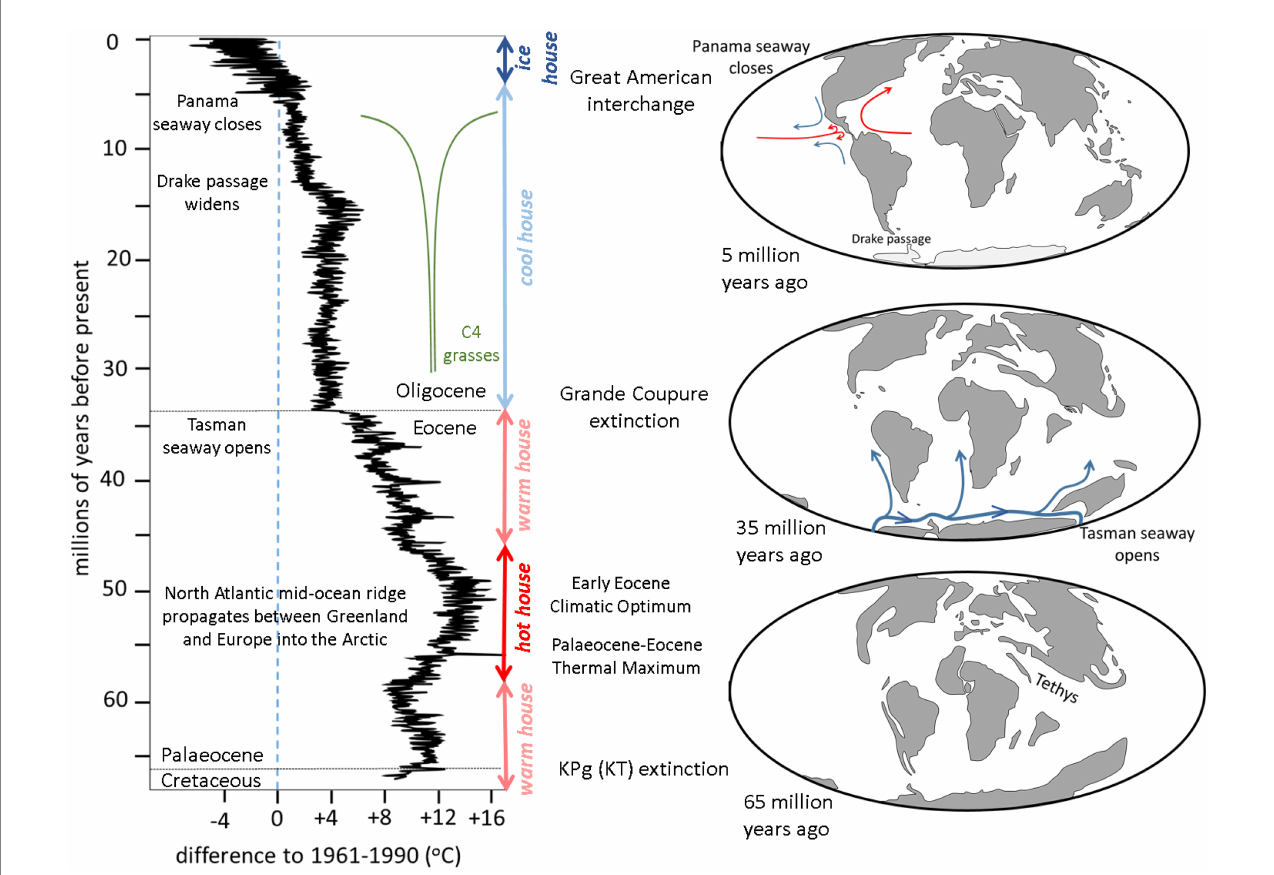
FIGURE 2 Summary of the changes in global temperatures (after Westerhold et al., 2020) and distribution of exposed land masses during the past 66 million years (after Scotese, 2022) relevant to latitudinal and longitudinal biodiversity